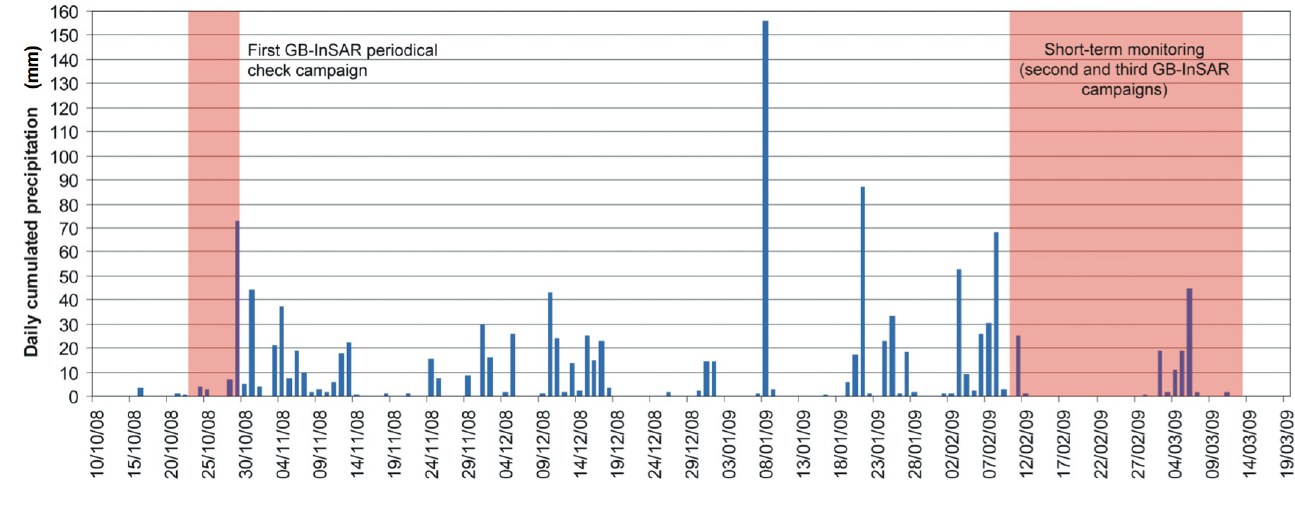
Figure 11. Daily cumulated precipitation recorded from October 2008 to March 2009, in the Castagnola